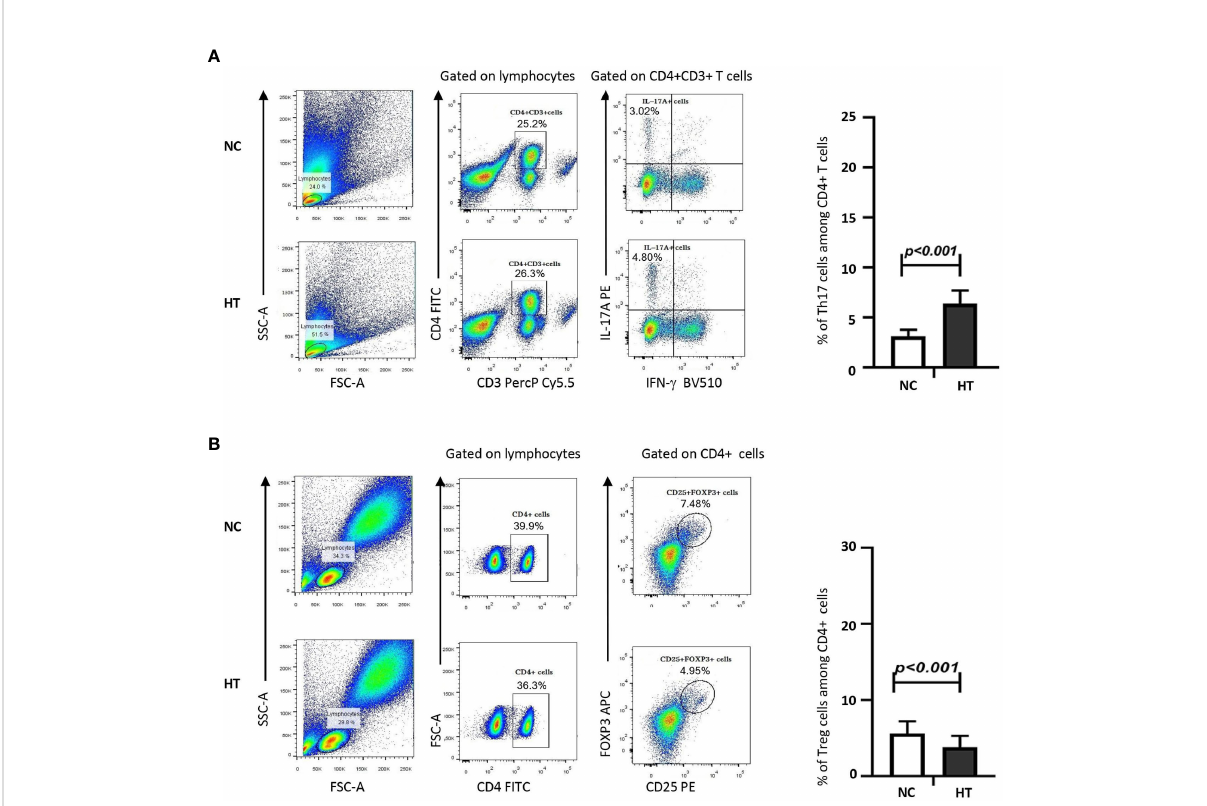
FIGURE 1 Peripheral blood Th17s were increased, whereas peripheral blood Tregs were decreased in HT patients compared with NC. The percentages of IL-17 + Th17s (A) or CD25 + FOXP3 + Tregs (B) among the peripheral blood CD4 + T cells of NC and HT patients was quanti fi ed by fl ow cytometric analysis. The gating strategy is shown on representative dot plots from a NC and a HT patient. The bar charts on the left-hand side summarize the data obtained for the NC (n = 21) and the HT (n = 53) groups. Differences between groups were assessed by t-test and the p-values are indicated.